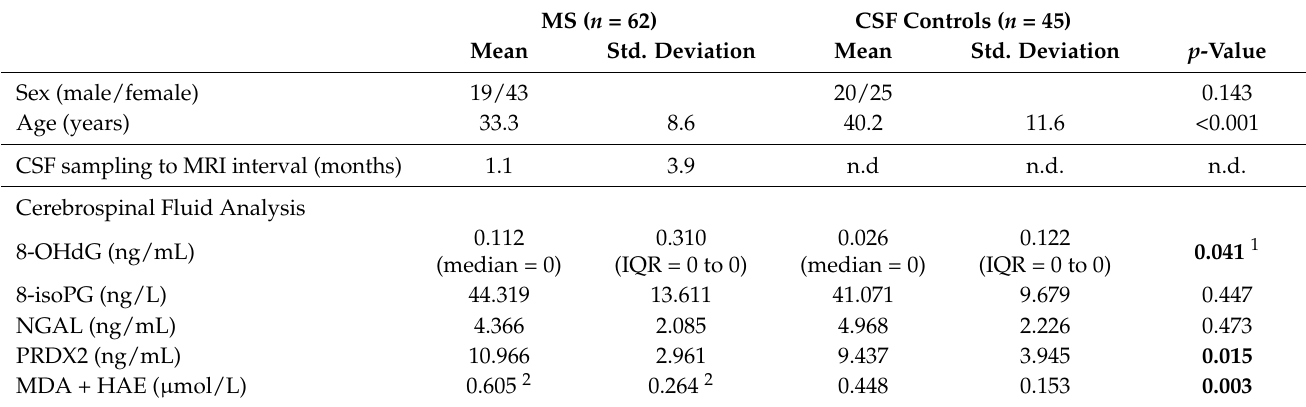
Table 2. Comparison of CSF biochemical markers in MS patients and